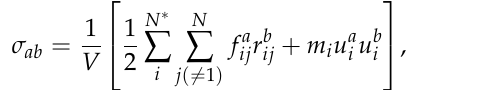
Figure 2. Determination of nanostructure stiffness in two directions. An ellipse is introduced into the pristine nanostructure by removing atoms in black area. Next, the structure is relaxed, and two analyses of microstructure stretching are performed in two different directions. Then, the stiffness is computed on the basis of the MD results.